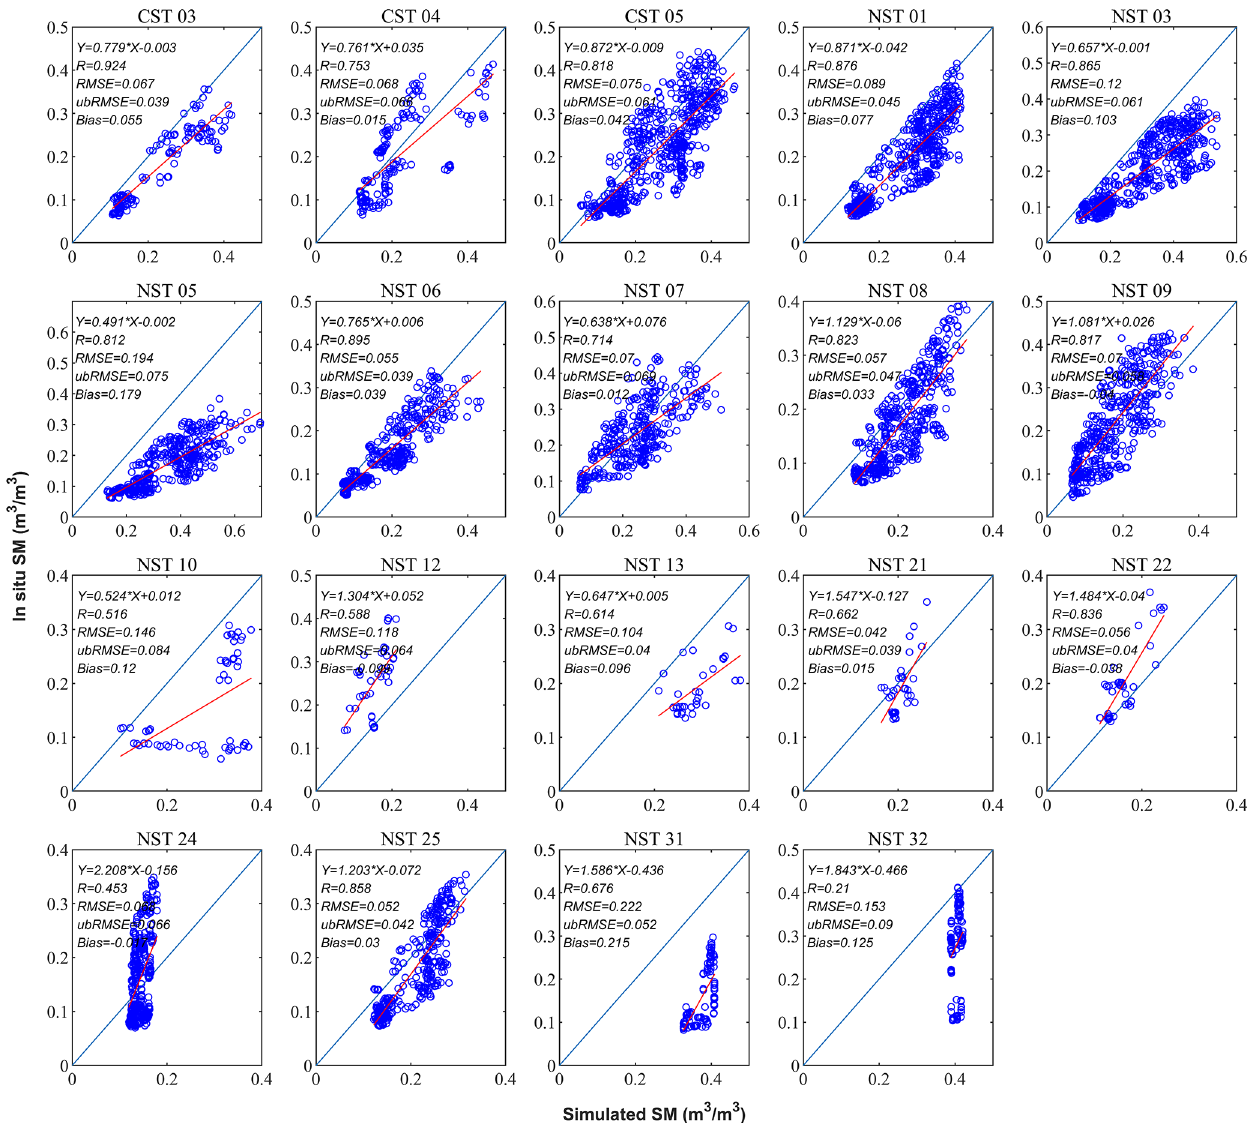
Figure 7. Comparison between the downscaled SM and in situ SM of the Maqu